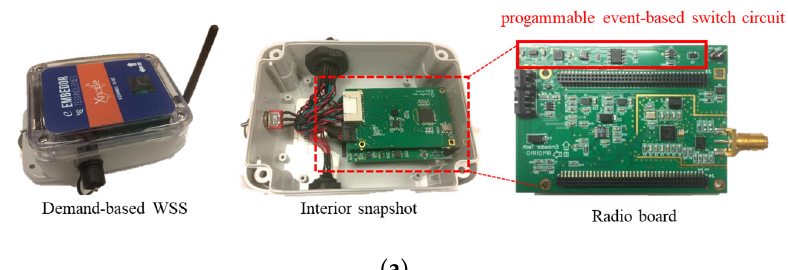
Figure 3. Illustration of sub-second impact detection in lab tests.